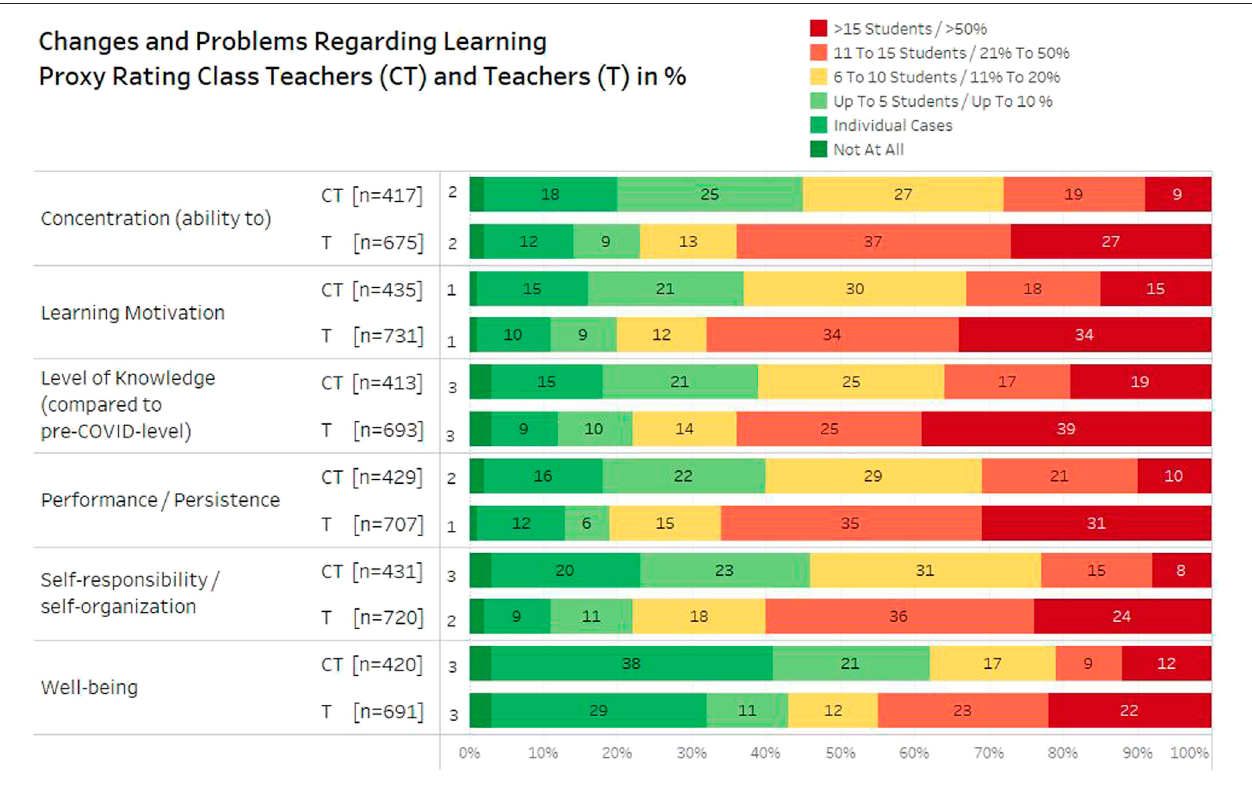
FIGURE 1 | Estimation of problems by teachers regarding